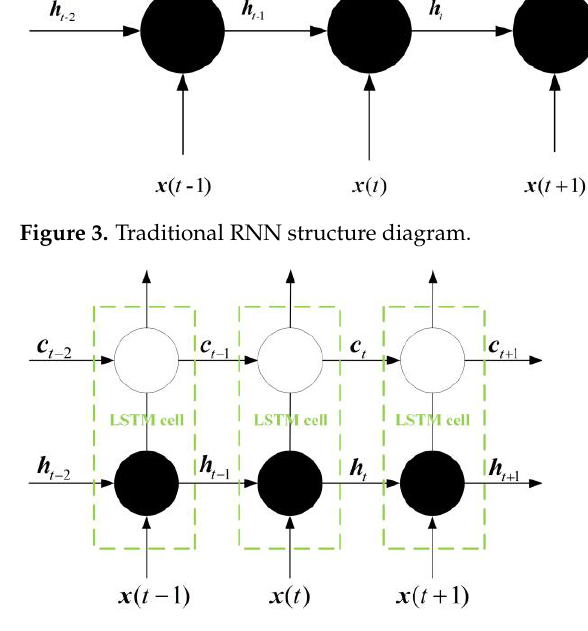
Figure 4. LSTM structure diagram.